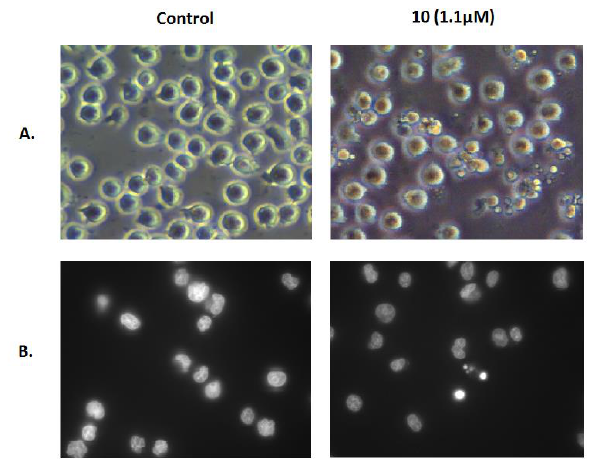
Figure 5. Morphological changes in Jurkat cells. Morphology of Jurkat cells untreated (Control) or treated with 1.1 μM compound 10 for 6 h was examined using a phase-contrast microscope ( A ) and fluorescence microscopy after Hoechst 33342 staining ( B ).